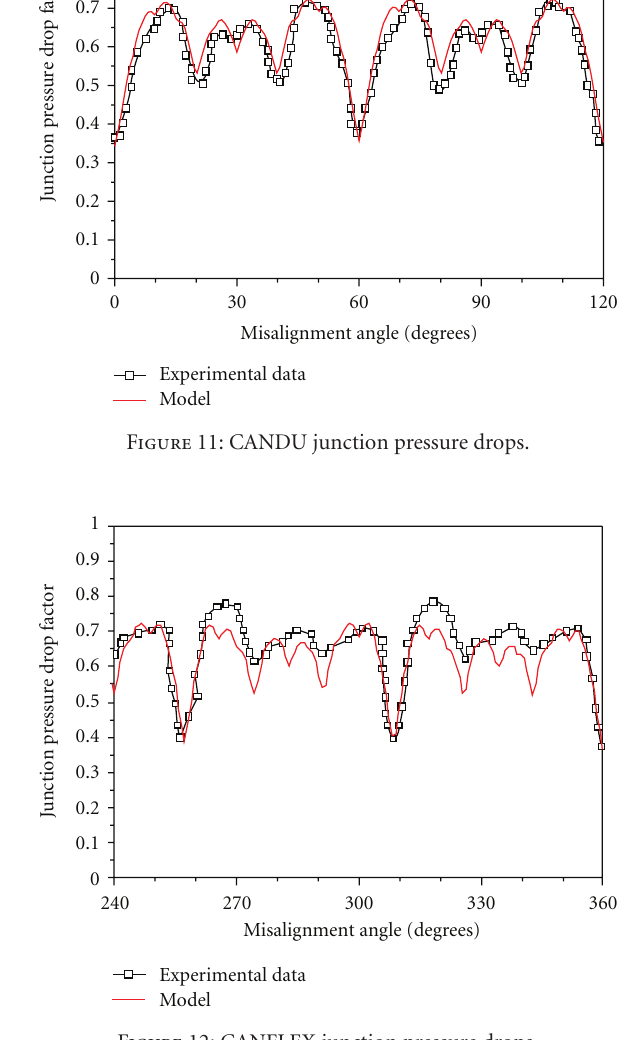
Figure 12: CANFLEX junction pressure drops.